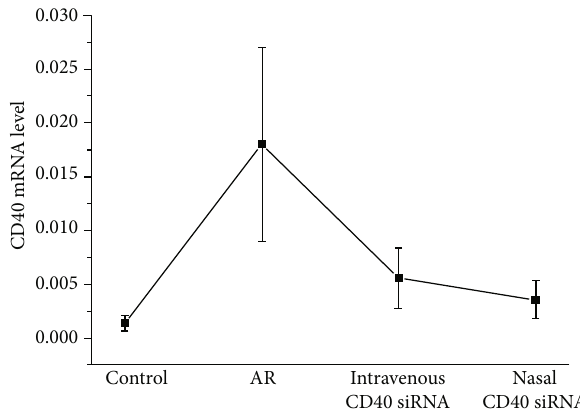
Figure 4: The mRNA level of CD40 in nasal tissues was detected by RT 2 -PCR. AR mice expressed signi fi cantly higher CD40 mRNA compared with control group. CD40 mRNA was signi fi cantly reduced in the mice treated with CD40 siRNA, both by intravenous and nasal methods. The mice treated with nasal CD40 siRNA expressed signi fi cantly lower CD40 mRNA than mice that received intravenous CD40 siRNA. P values < 0.05 were considered as signi fi